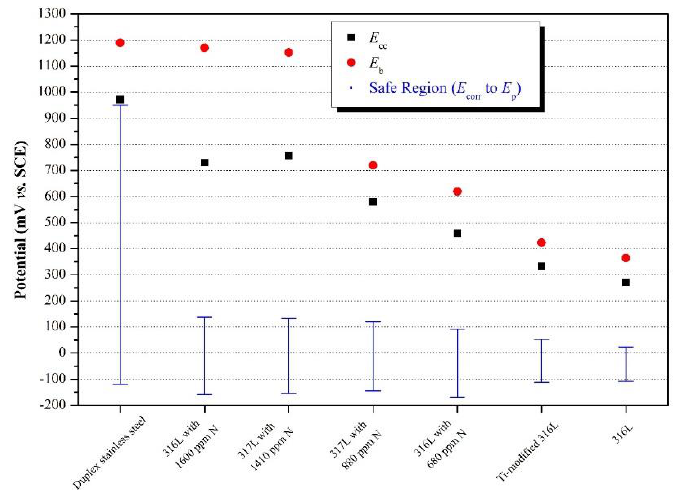
Figure 11. Comparison between selected corrosion resistance characteristics of several stainless steels in Hank’s solution, illustrating the effect of nitrogen concentration in the steel [37]. Reproduced with permission from De Gruyter.